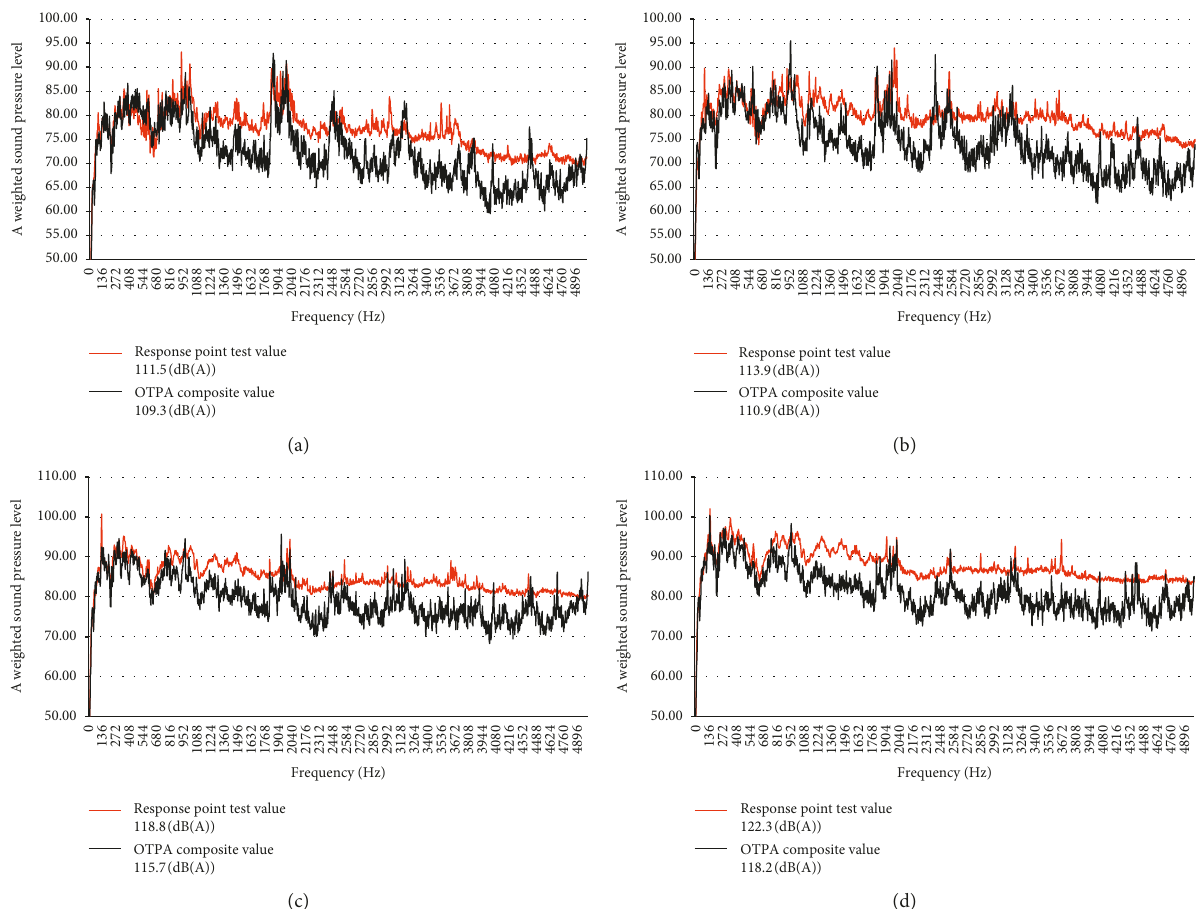
Figure 9: Spectrum diagram of the actual test noise and structural radiated noise at the target response point. (a) 200km/h. (b) 250km/h. (c) 300km/h. (d) 350km/h.